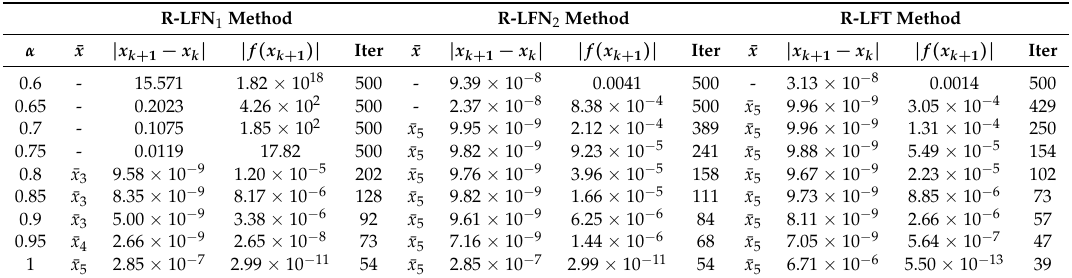
Table 4. Fractional Newton and Traub-type results for f 1 ( x ) with Riemann–Liouville derivative and initial estimation x 0 = 10 4 i